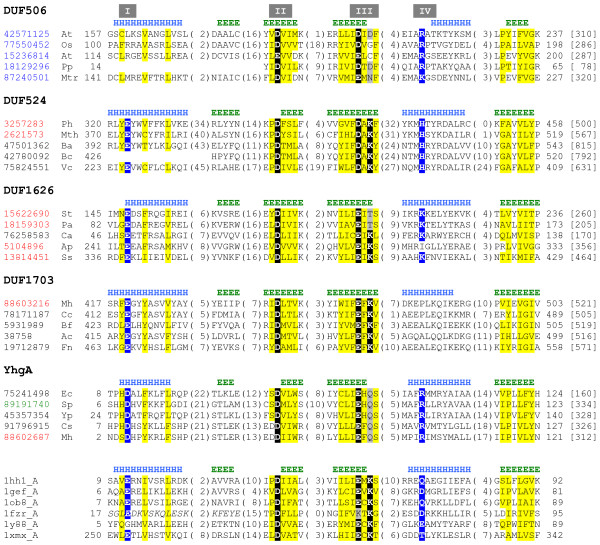
Novel PD-(D/E)XK nuclease families. Multiple sequence alignment of representative sequences from newly detected families and selected PD-(D/E)XK nuclease structures for the conserved structural core. Sequences are labeled according to gi number or PDB code and an abbreviation of the species name: Ac Azotobacter chroococcum, Ap Aeropyrum pernix, At Arabidopsis thaliana, Ba Bacillus anthracis, Bc Bacillus cereus, Bf Bacteroides fragilis, Ca Chloroflexus aurantiacus, Cs Chromohalobacter salexigens, Ct Clostridium tetani, Ec Escherichia coli, Fn Fusobacterium nucleatum, Mh Methanospirillum hungatei, Mtr Medicago truncatula, Mth Methanothermobacter thermautotrophicus, Os Oryza sativa, Pa Pyrobaculum aerophilum, Ph Pyrococcus horikoshii, Pp Pinus pinaster, Sp Sodalis phage, Ss Sulfolobus solfataricus, St Sulfolobus tokodaii, Vc Vibrio cholerae, Yp Yersinia pesti. Sequence gi numbers are colored according to taxonomy: with bacterial in black, archeal in red, eukaryotic in blue and viral in green. The first and last residues numbers are indicated before and after each sequence with total sequence length following in square bracket. The numbers of excluded residues are specified in parentheses. Residue conservation is denoted with following scheme: uncharged, highlighted in yellow; charged or polar highlighted in grey; small, letters in red. Active site PD-(D/E)XK signature residues are highlighted in black while other conserved polar/charged residues in alternative active site positions are highlighted in blue. Restriction endonuclease-like motifs (I-IV) are labeled on the top. Predicted (gi:42571125, gi:3257283, gi:15622690, gi:88603216 and gi:75241498) and observed (pdb:1hh1) secondary structure elements (E, β-strand; H, α-helix) are indicated above the sequences. Italicized sequence corresponds to domain-swapped region of 1fzr.